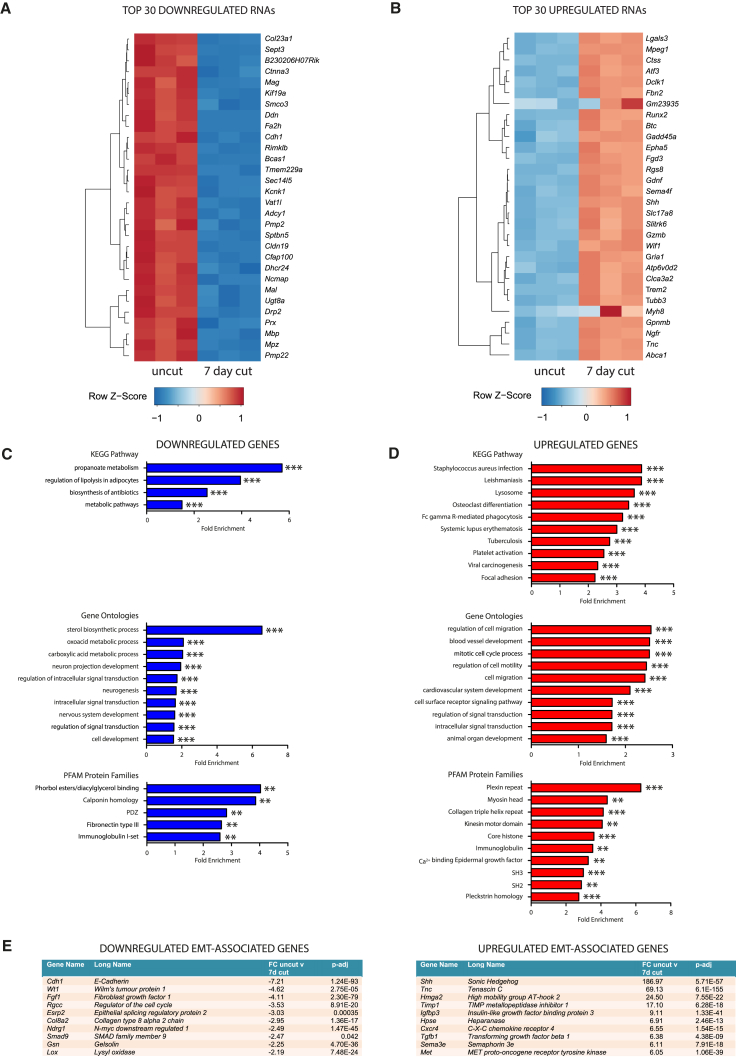
RNA-Seq Analysis Identifies Enrichment of EMT Genes after Nerve Injury(A) A heatmap of the top 30 significantly downregulated genes between uncut and 7-day cut nerves (n = 3, adjusted p value [p-adj] < 0.05).(B) A heatmap of the top 30 significantly upregulated genes between uncut and 7-day cut nerves (n = 3, p-adj < 0.05).(C and D) Enriched KEGG pathways, GO terms, and protein families (PFAM) for (C) downregulated genes and (D) upregulated genes from RNA-seq analysis 7 days after nerve cut compared to the uncut nerve (n = 3). ∗p-adj < 0.05; ∗∗p-adj < 0.01; ∗∗∗p-adj < 0.001.(E) Enrichment analysis of EMT genes from the RNA-seq study showing the 10 most downregulated and upregulated mRNAs (p-adj < 0.05).